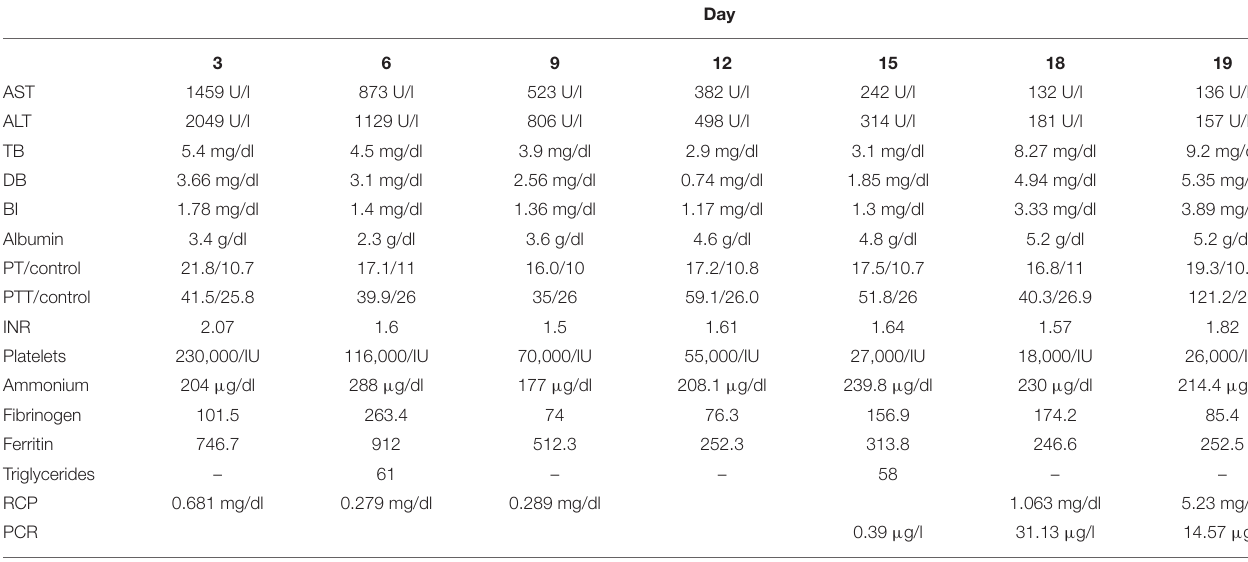
TABLE 1 | Laboratory and studies evolution.